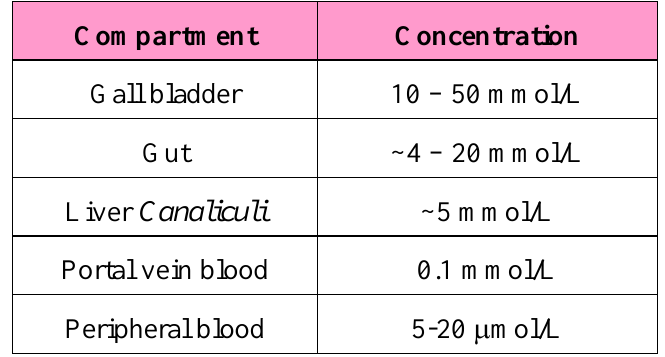
Table 1. The concentration of bile salts in different body compartments of humans [5,